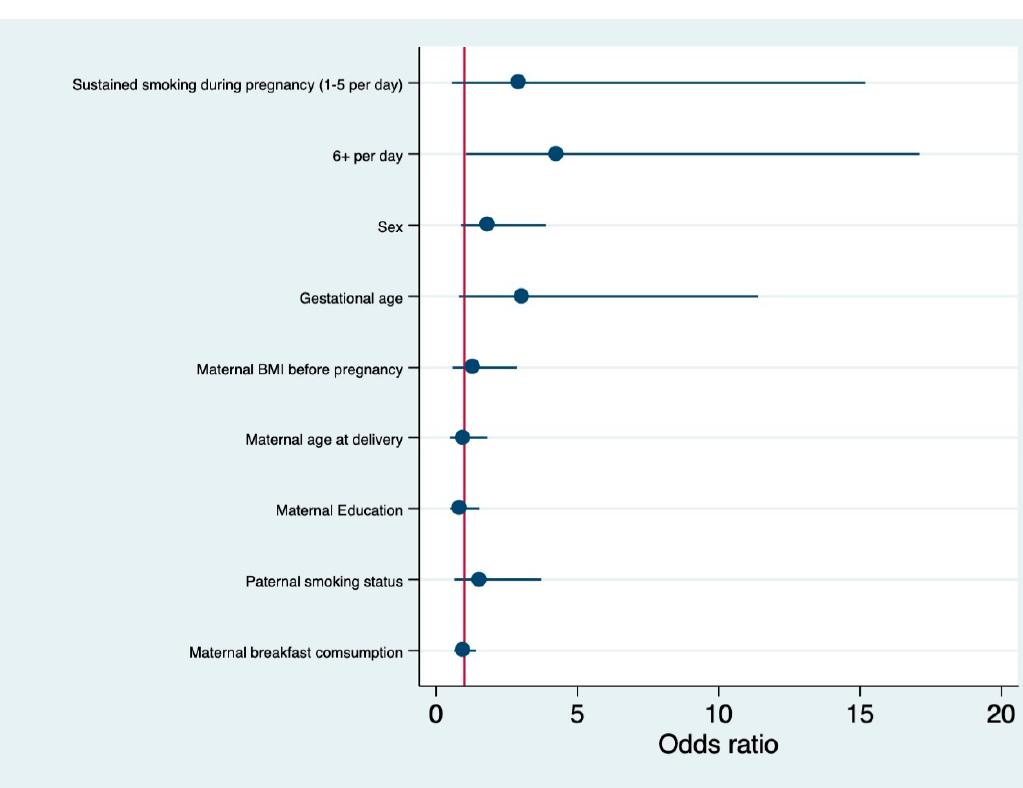
Figure 2. Adjusted odds ratios for missing teeth.